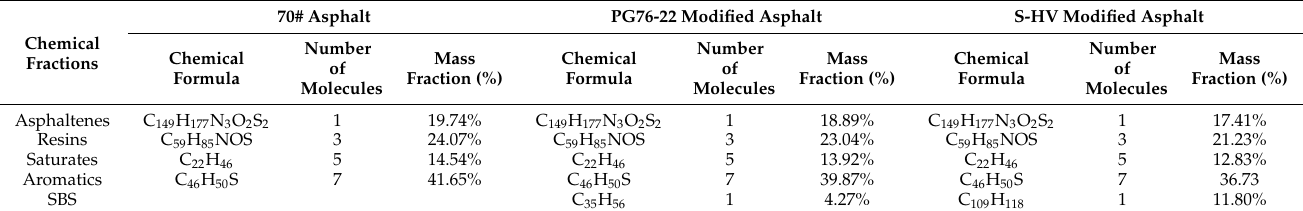
Figure 2. Structure of unit cell of four-component asphalt.